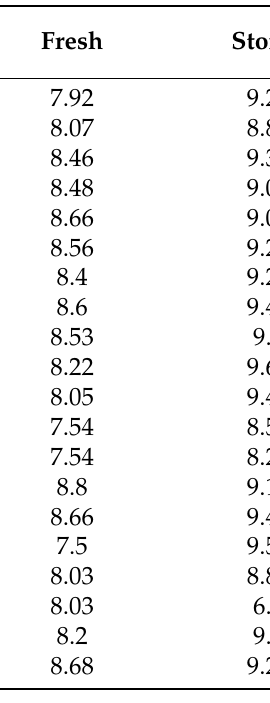
Table 1. The effects of storage time and temperature on albumen